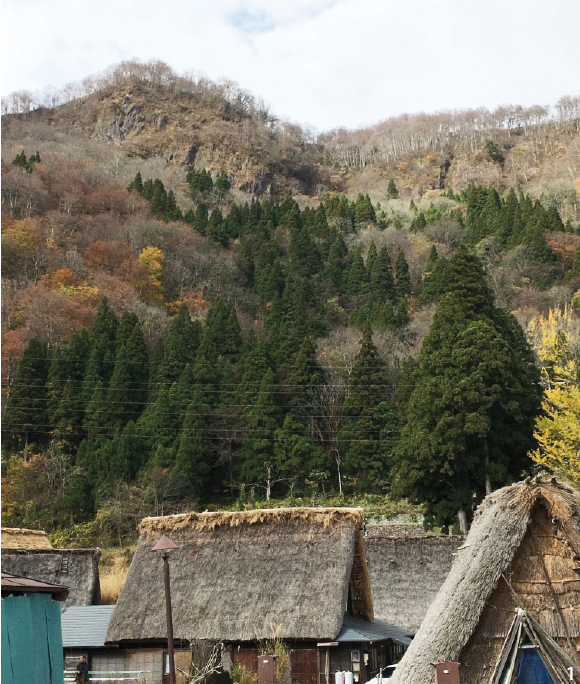
Figure 1 Roofs in Ogimachi village, Shirakawa-go (Source: the